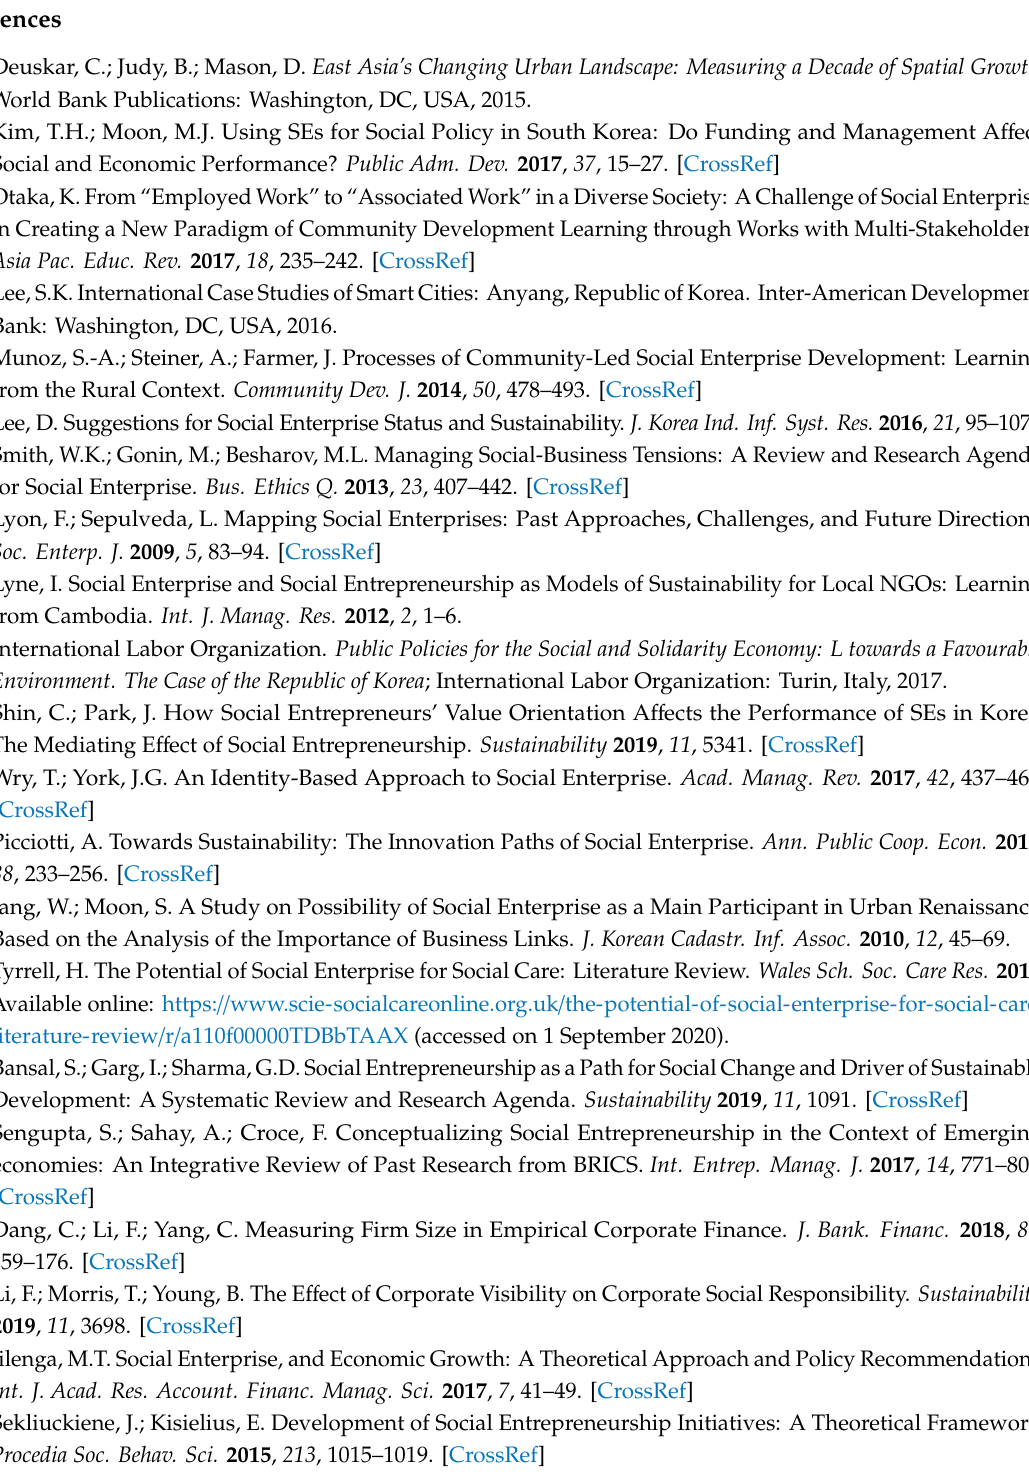
The background color and bold text is necessary for distinguishing the variables from the